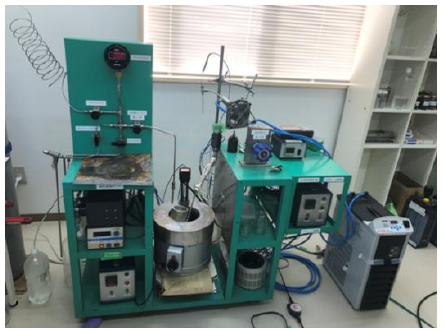
Figure 6. Device diagram of the liquid flow reactor [18].